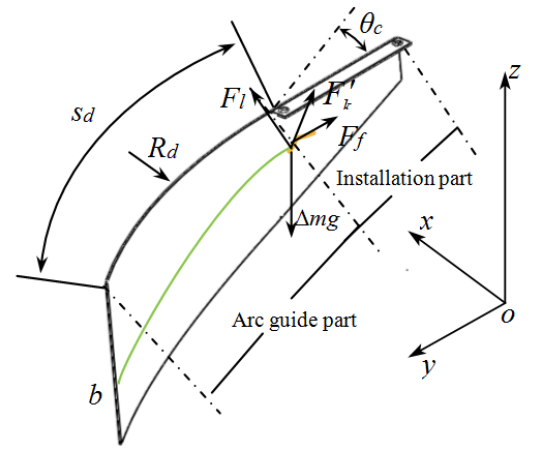
Figure 9. Analysis of the structure of the deflector and the movement of straw.